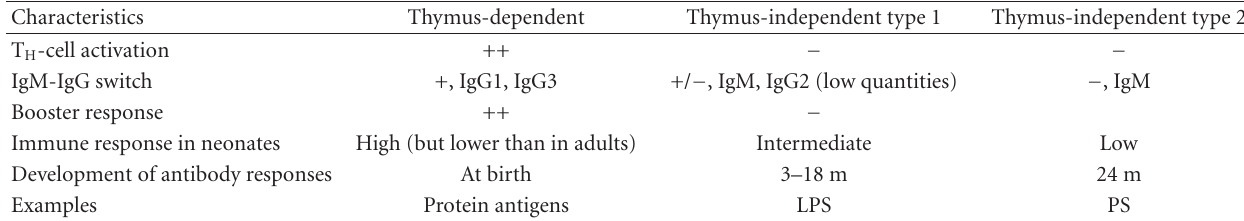
Table 1: Characteristics of thymus-dependent and thymus-independent